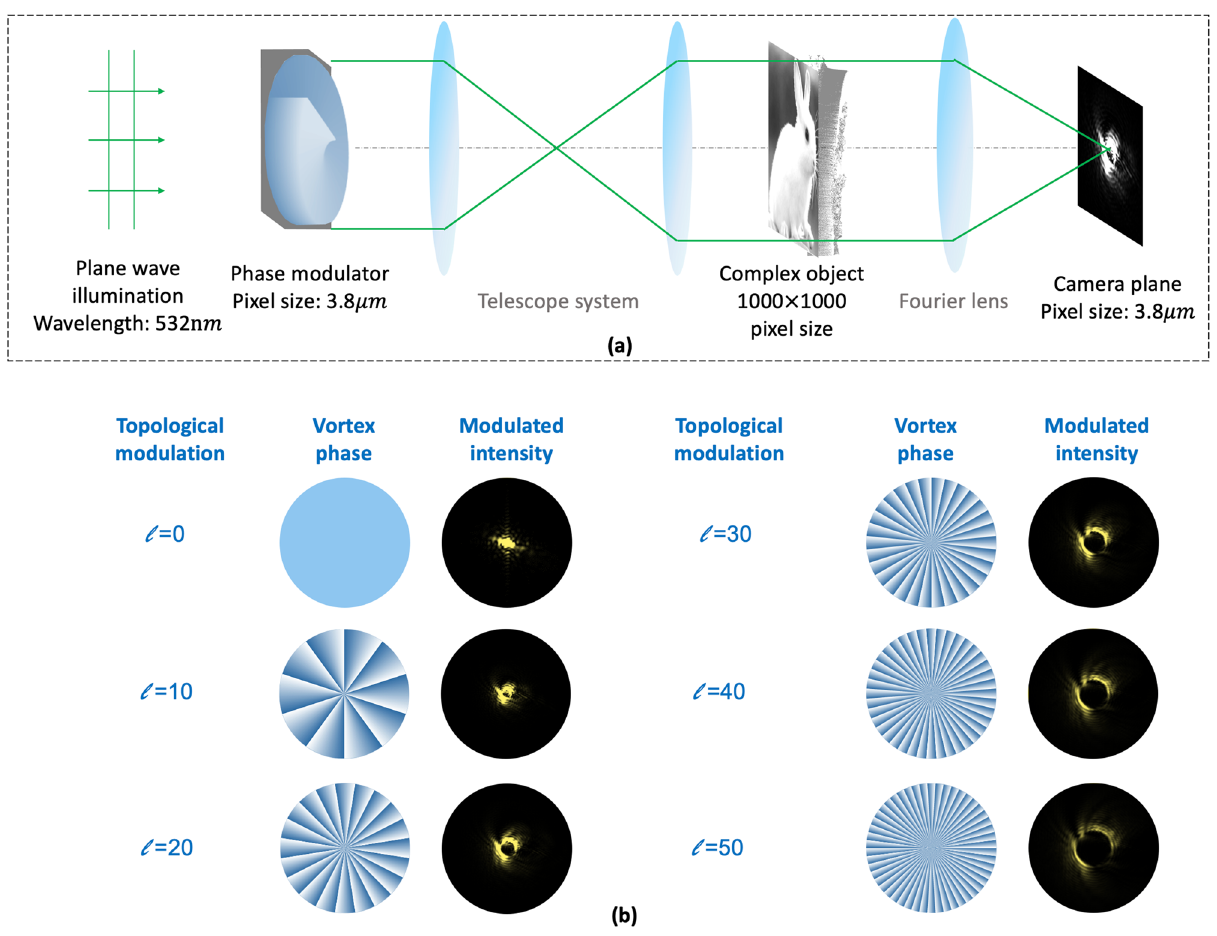
Figure 2. (a) Schematic of the coherent diffraction imaging system with topological modulations. (b) Vortex phases on the phase modulator and modulated intensities with topological charge l from 0 to 50 at an interval of